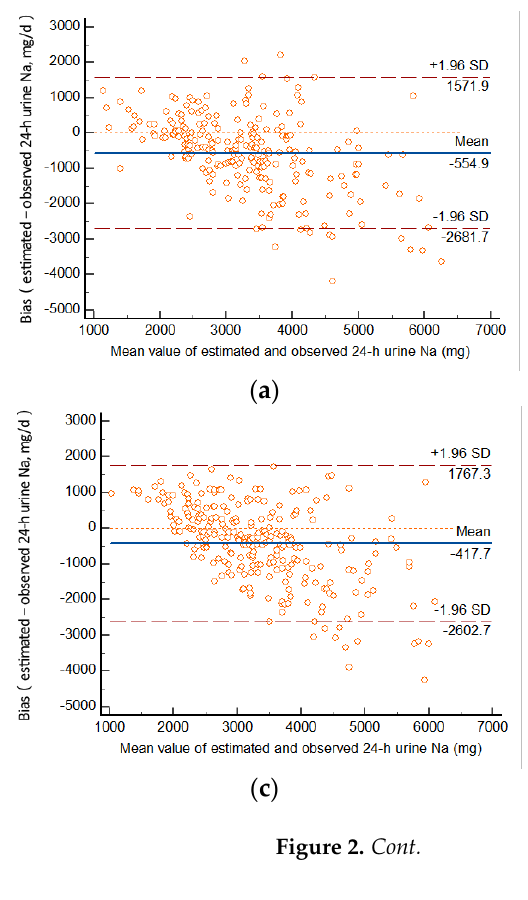
Figure 1. Bland – Altman plot of the bias (difference) between predicted and measured 24-h urinary sodium excretion in summer, based on INTERSALT equation ( a ) and Tanaka equation ( b ) in the morning, INTERSALT equation ( c ), Tanaka equation ( d ) and Sun’s equation ( e ) in the afternoon, INTERSALT equation ( f ) and Tanaka equation ( g ) in the evening, and INTERSALT equation ( h ), Tanaka equation ( i ) and Kawasaki equation ( j ) overnight.